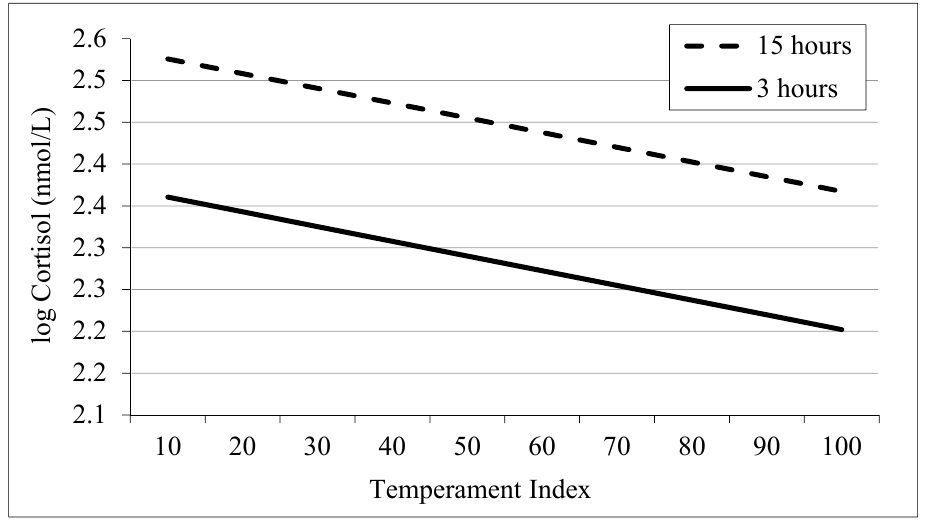
Figure 2. Average TIndex effect on (log) cortisol values at slaughter. Trendlines per slaughter group, estimated by regression analysis (R 2 = 0.30).